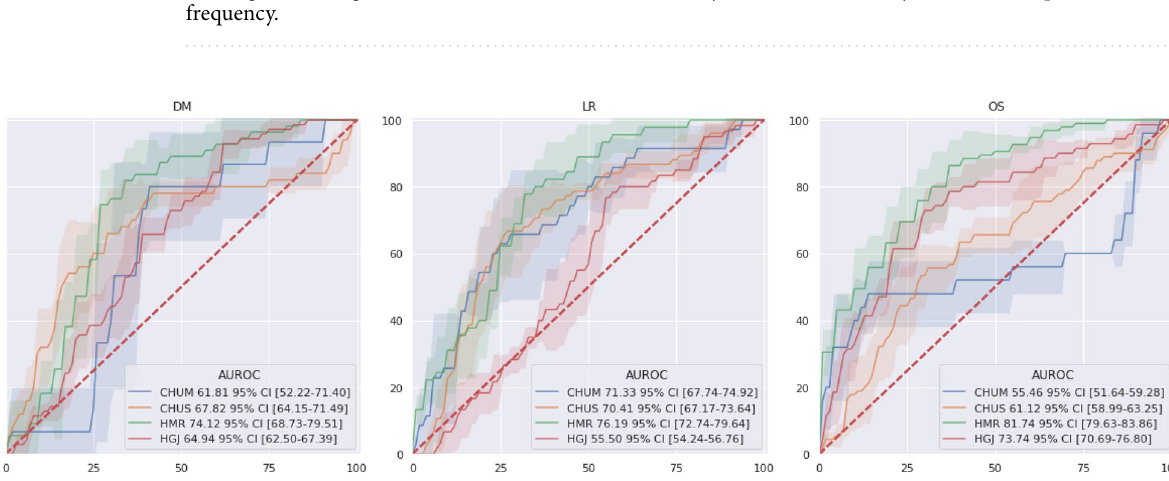
Figure 5. ROC curves for the proposed PreSANet evaluated in a single-site cross-validation. Figures presented are mean AUC [ 95% CI] over 5 trials. Training and validation used is shown in Fig. 8C. Figure created with seaborn/matplotlib v0.11.2